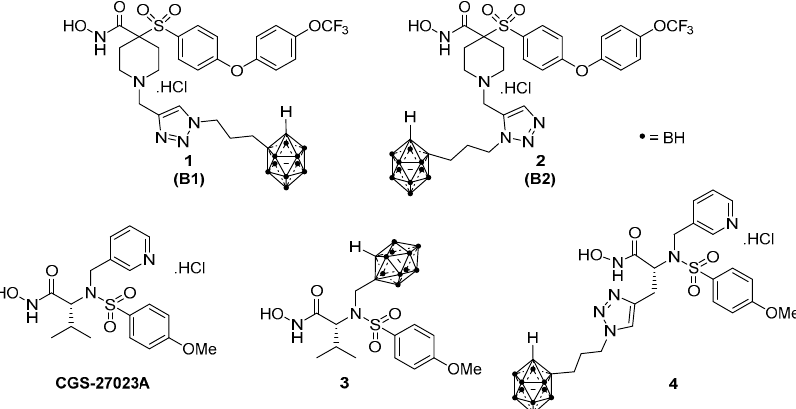
Figure 1. Previously synthesized carborane-containing sulfones 1 (1,4-triazole) and 2 (1,5-triazole) for BNCT based on MMP inhibitors SC-78080 and SC-77964, MMP inhibitor CGS-27023A, and CGS-27023A analogs 3 and 4 .